Question: Reading the figure, is the described quantity rising or falling?
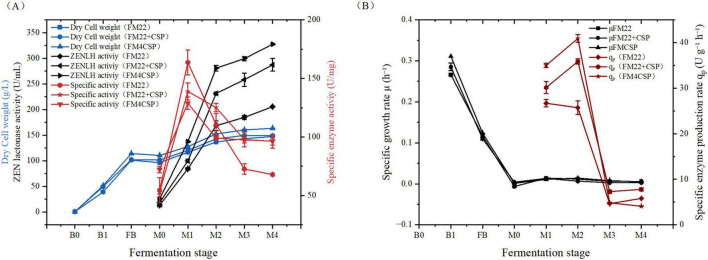
Answer: increasing